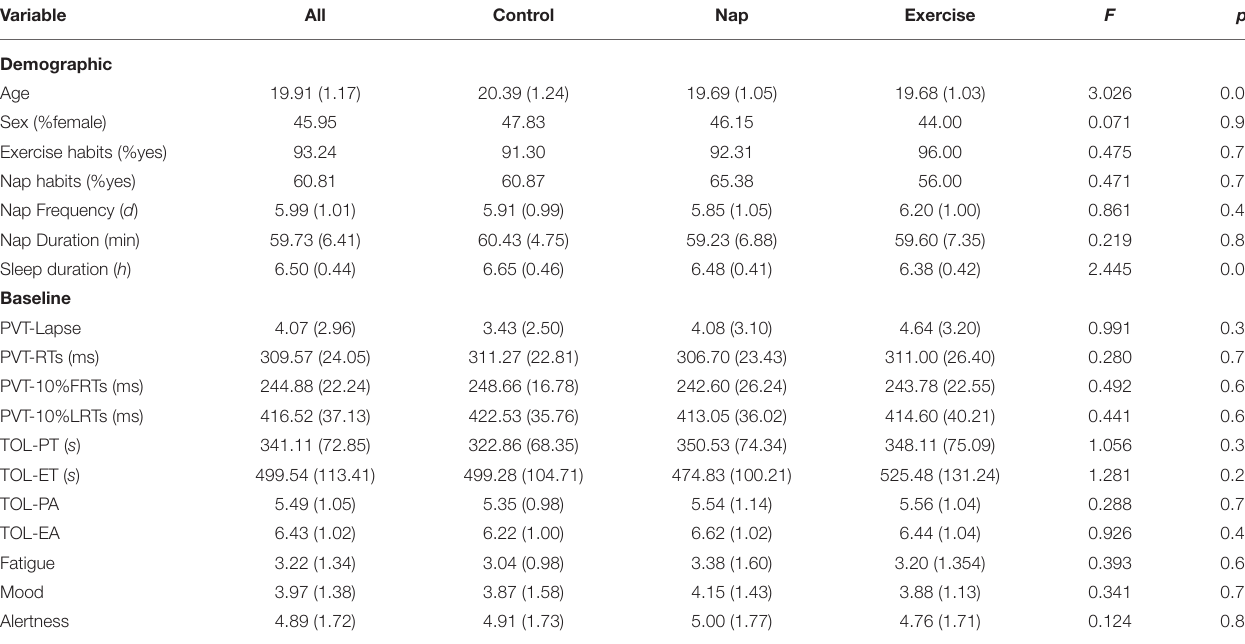
TABLE 1 | Potential confounding factors. Variable